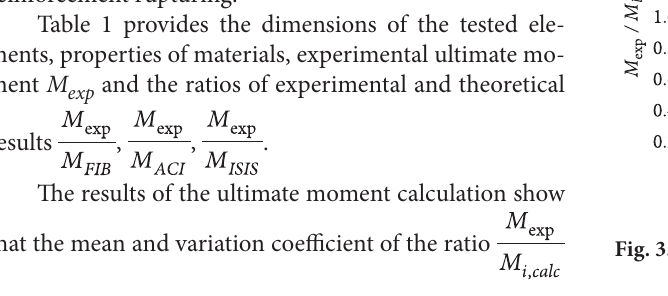
Table 1. Database of concrete elements with FRP reinforcement; results of experimental and calculated ultimate moments